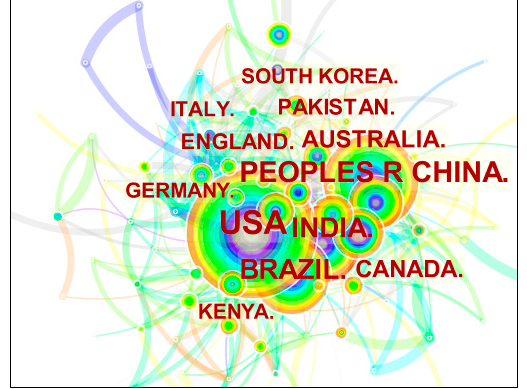
Figure 4. Country cooperation network map.